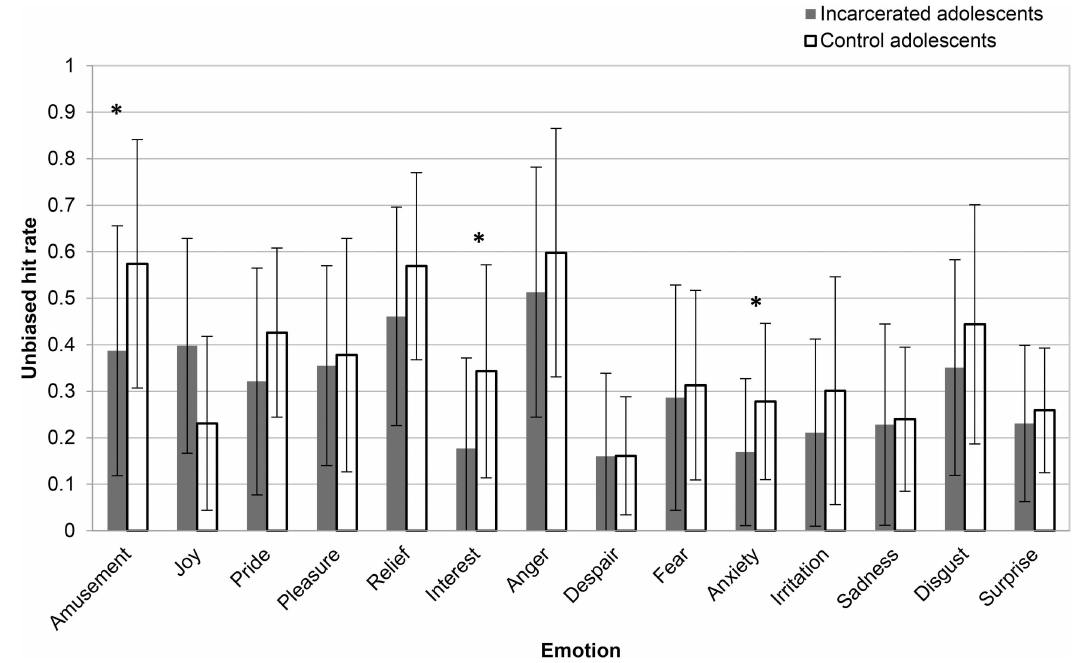
Fig 1. Means and standard deviations for the emotion recognition task for each group. * The mean difference betweenthe two groupsis significantat p <